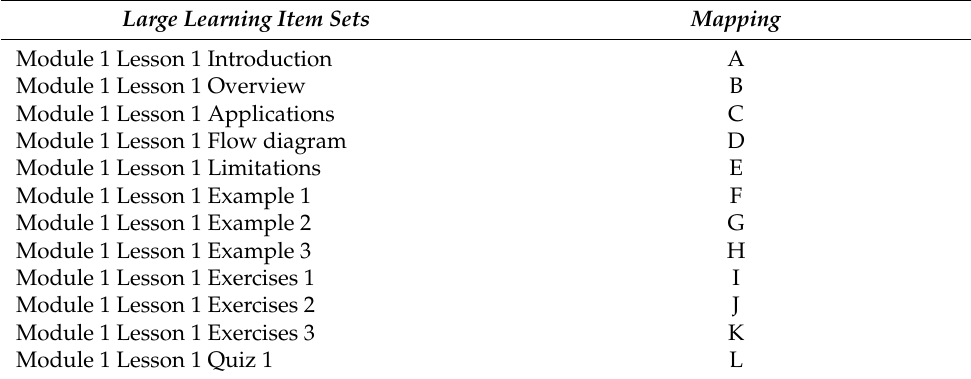
Table 4. Mapping of large learning item sets.